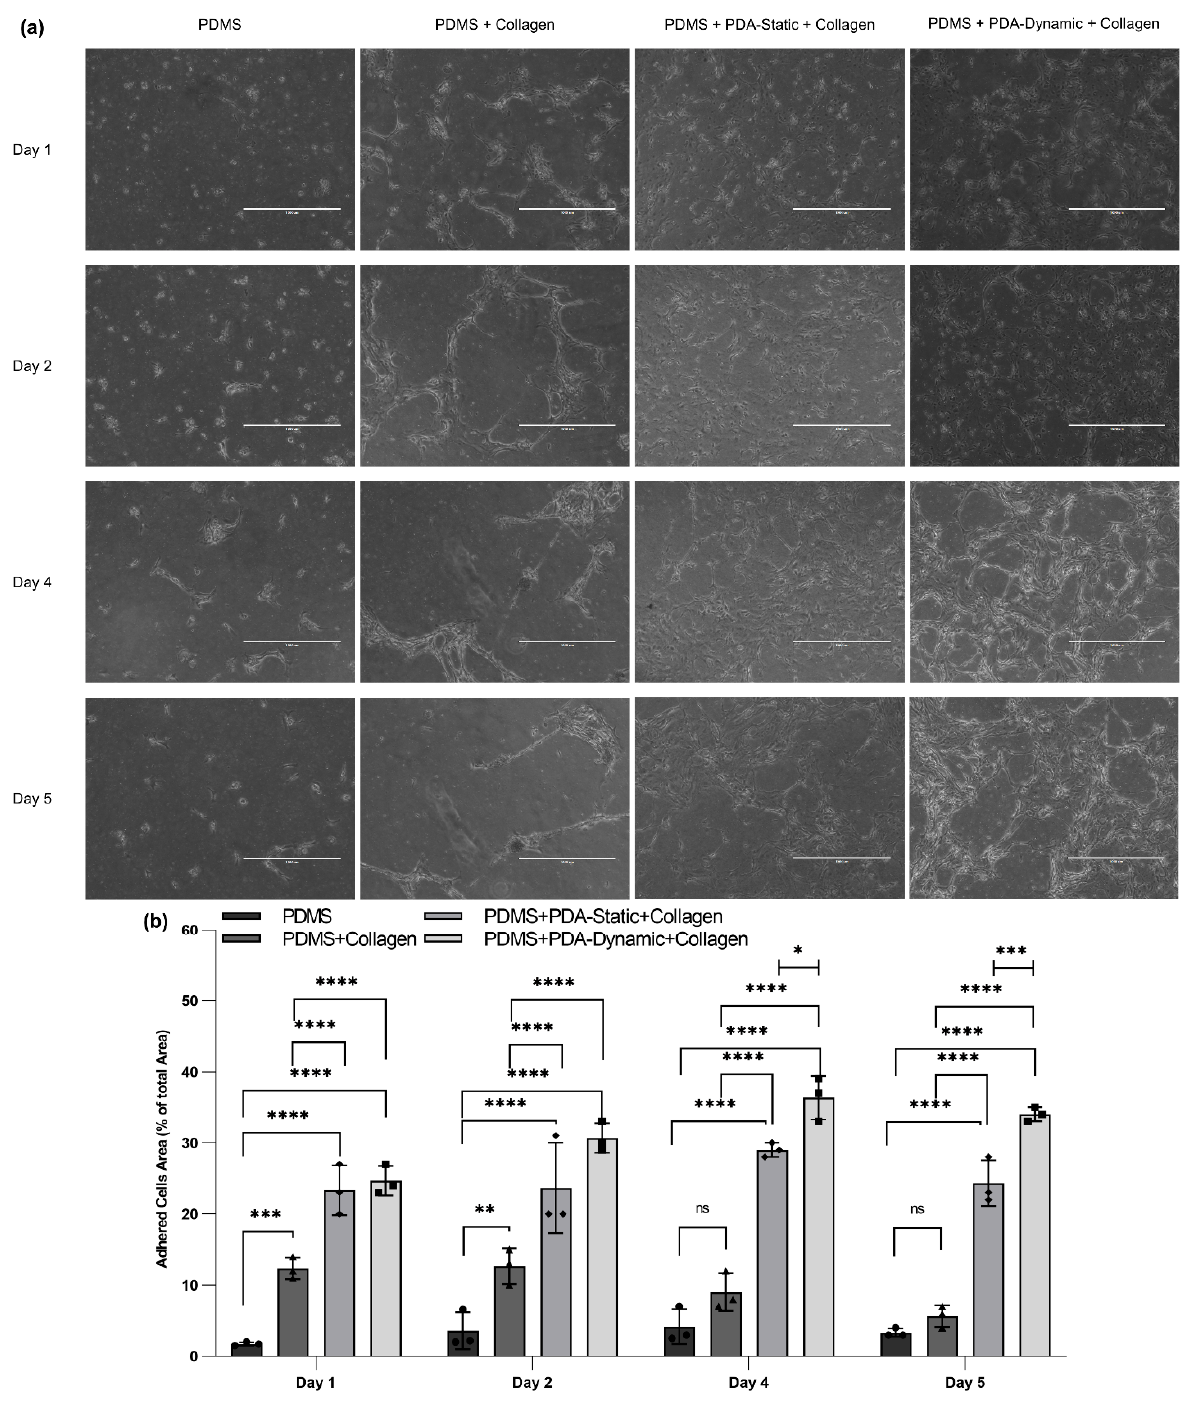
Figure 2. The comparison of cultured human bronchial epithelial cells (HBECs) on PDMS and treated surfaces: ( a ) Bright- field image of HBECs adhered on native, collagen-coated, PDA-static-collagen-coated, and PDA-dynamic-collagen-coated surfaces at Day 1, 2, 4, and 5 and ( b ) the adhered cells area as a percentage of the total area using bright field images that were quantified with ImageJ software. Scale bars are 1000 µm. * p ≤ 0.05 , ** p ≤ 0.01, *** p ≤ 0.001, and **** p ≤ 0.0001.